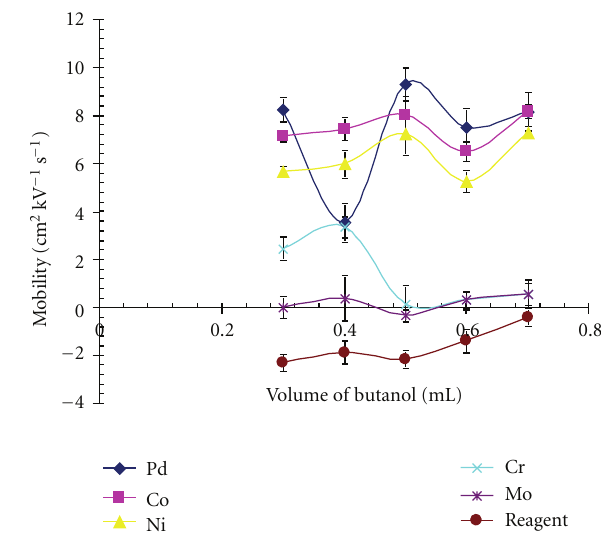
Figure 2: Variation in migration velocity with concentration of borate bu ff er.